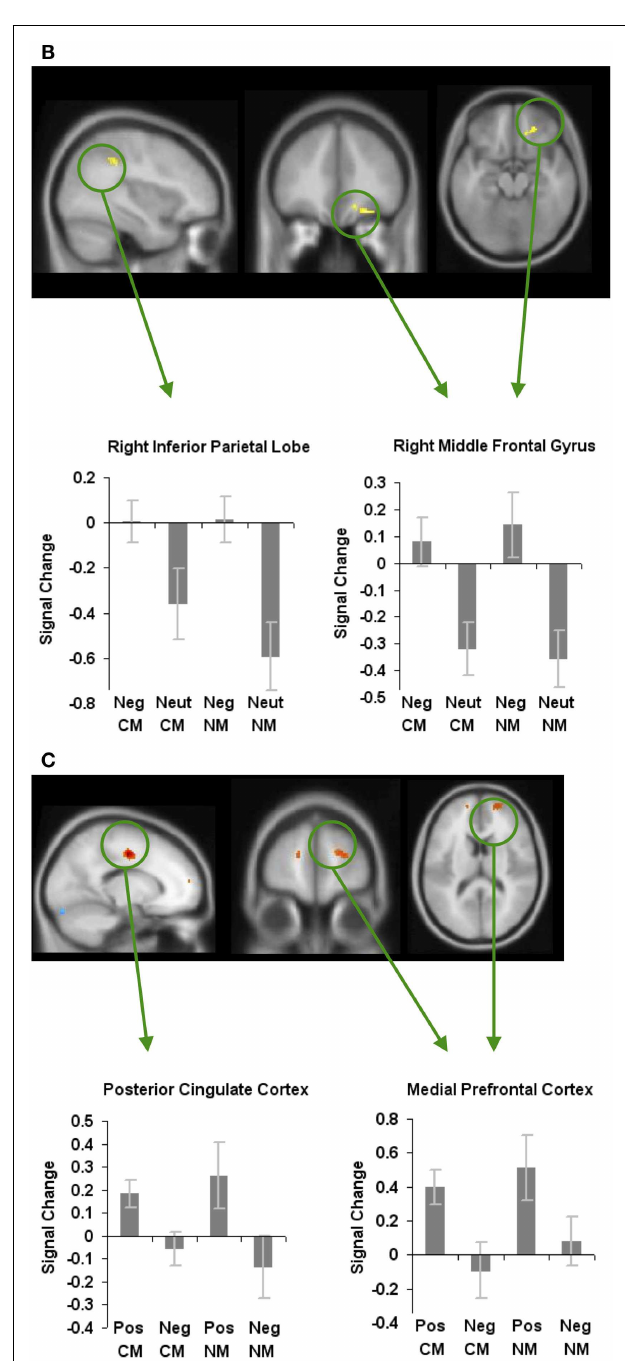
FIGURE 3 |Whole-brain activation showing signal change for affective stimuli modulating metaphoric processes in general: (A) reveals signal change for positively valenced metaphors versus neutral metaphors, (B) reveals signal change for negatively valenced metaphors versus neutral metaphors, and (C) reveals signal change for positively valenced metaphors versus negatively valenced metaphors . All clusters are illustrated at a threshold of p < 0.001 (uncorrected) combined with a cluster size of at least 50 voxels or 400mm 3 in volume. Mean beta weights for each condition extracted from the clusters illustrated in the specific contrasts of interest are revealed in the bar